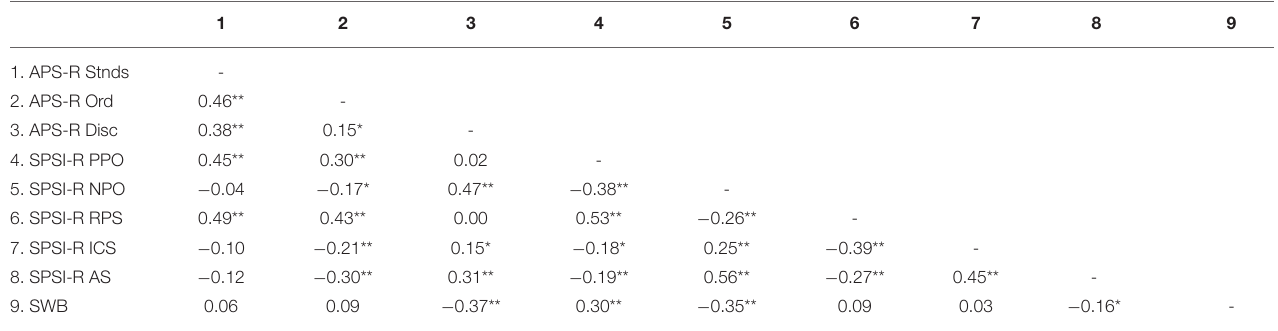
TABLE 2 | Intercorrelations amongst measures of perfectionism, social problem solving and subjective well-being ( N = 202). 1